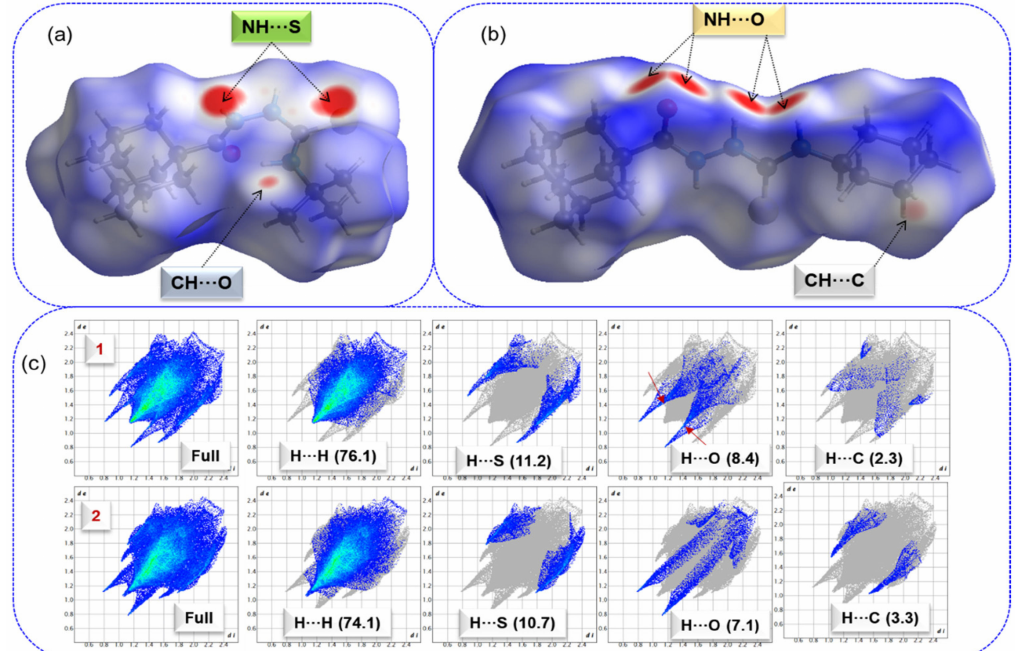
Figure 2. Hirshfeld surface shows the short intercontacts (red areas) observed in ( a ) compound 1 , ( b ) compound 2 , and ( c ) 2D-fingerprint plots for selected intercontacts, and their contributions are shown in parentheses. Arrow marks represent the intermolecular C–H ··· O interactions in 1